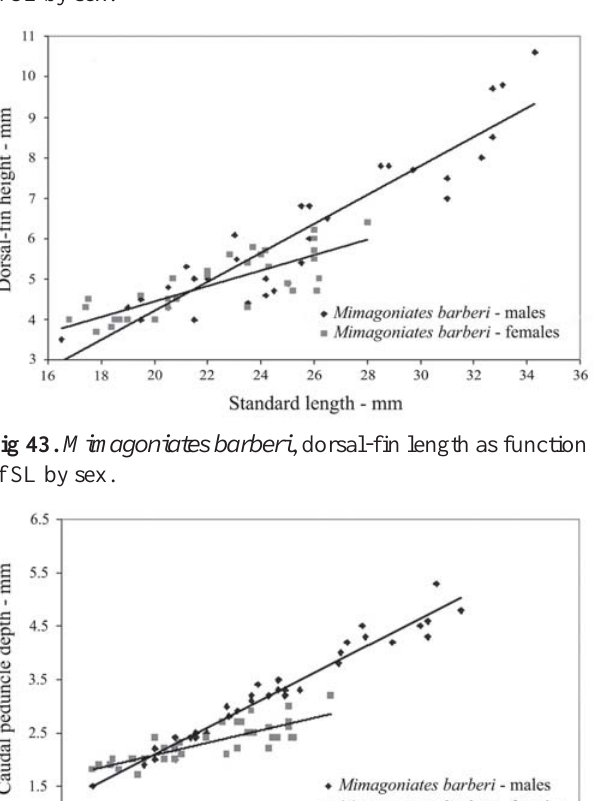
Fig. 42. Mimagoniates barberi , pelvic-fin length as function of SL by sex.